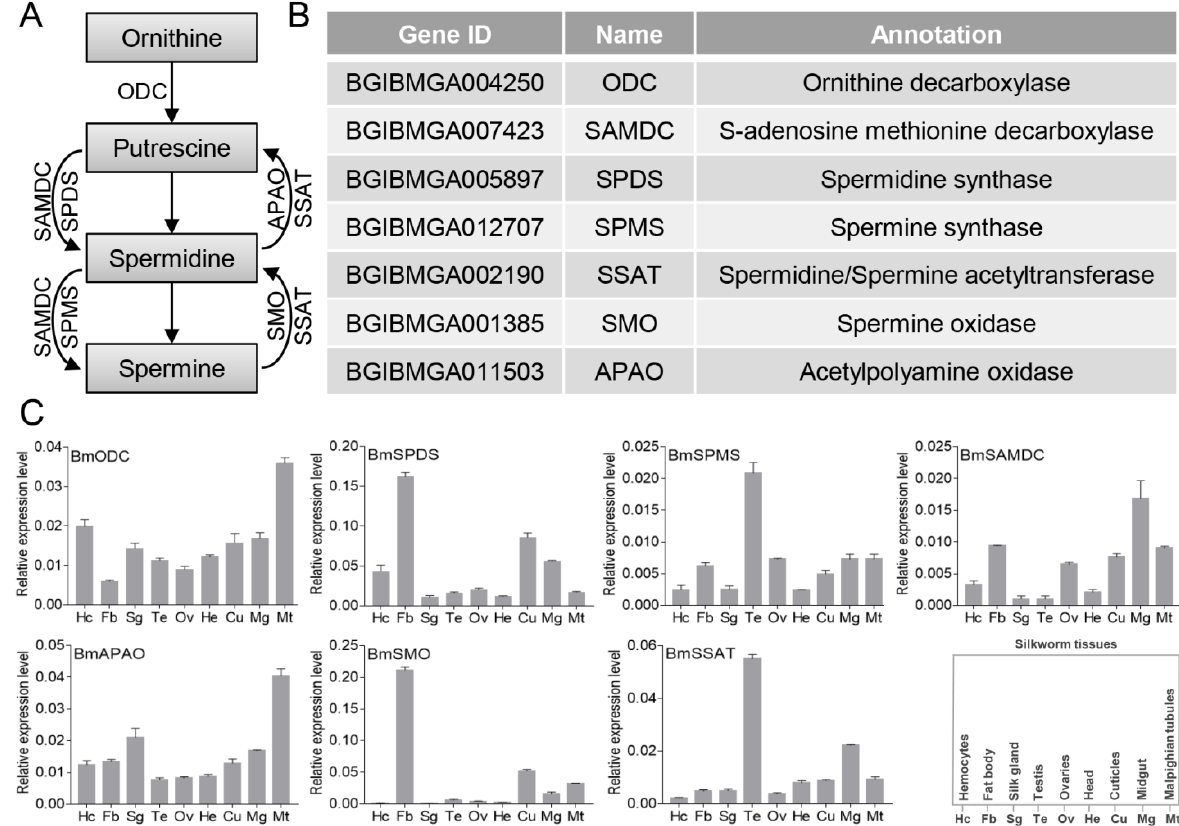
Figure 1. Identification and expression profiles of polyamine pathway genes in the silkworm. ( A ) A schematic representation of the polyamine biosynthesis pathway. ( B ) Identification and annotation of polyamine pathway genes. ( C ) Tissue expression profile of polyamine pathway genes in the silkworm.